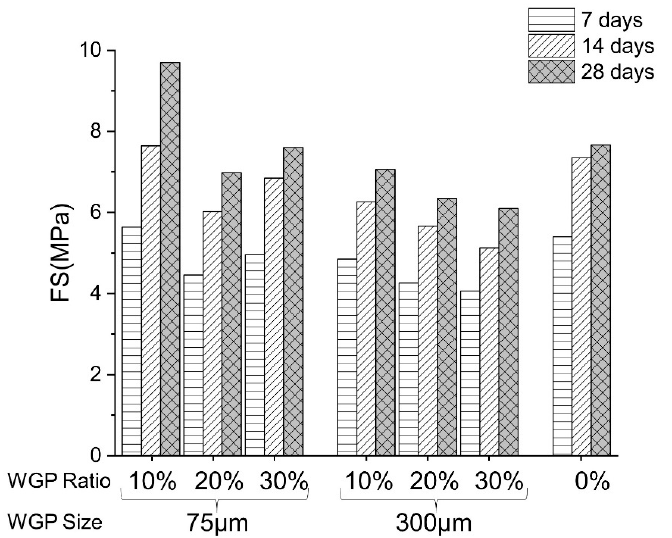
Figure 6. The FS of mortar containing WGP with different proportions by mechanical activation at different curing times.